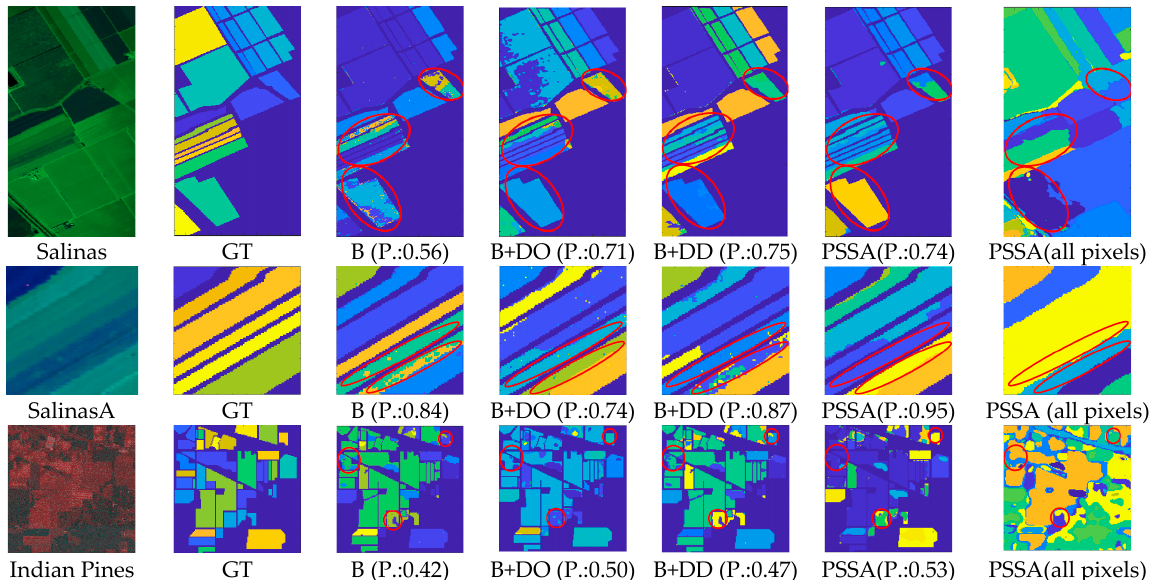
Figure 8. Original images of the Salinas ( top ), SalinasA ( middle ) and Indian Pines ( bottom ), the ground truths and the classification results. in different steps. All the results are for labelled pixels only except those from our approach. Areas in red circles in each row are for particular attention to compare the results of classification. Table 4. Clustering results on three public datasets, where “NaN” represents unavailable results due to out of memory, and “-” denotes no referred results. Bold represents the best result of all methods, and underline represents the best result of unsupervised